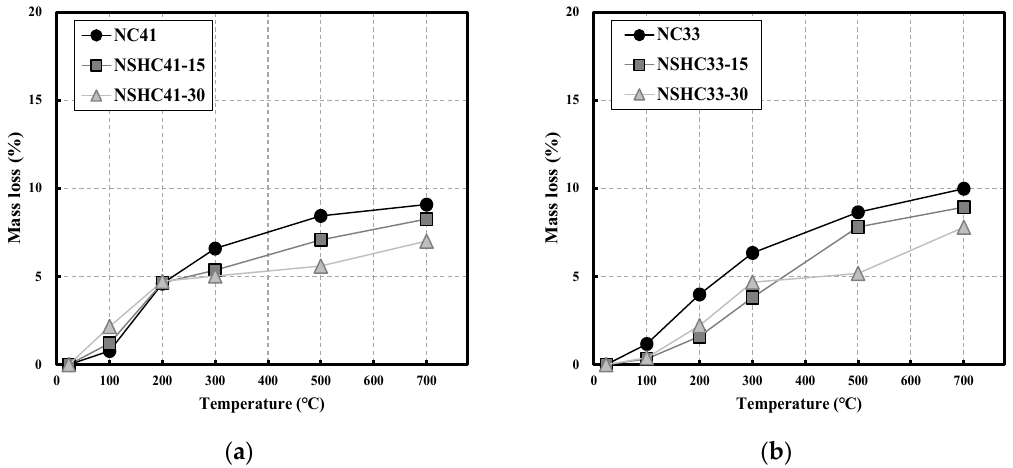
Figure 6. Mass loss of NC and NSHC after high ‐ temperature exposure: ( a ) W/B 41; ( b ) W/B 33. For W/B 33 (Figure 6b), NC33 showed a higher mass loss (%) than that of the speci ‐ mens with NSH mixed in all temperature ranges. Similar to NC41, the mass loss was 6.34% up to 300 °C, and at 700 °C, the mass loss increased to approximately 10%. NSHC33 ‐ 30 showed a by 23% higher mass loss than NSHC33 ‐ 15 up to 300 ℃ , but at higher tempera ‐ tures, NSHC33 ‐ 15 showed a higher mass loss value. NSHC33 ‐ 15 showed a higher mass loss (%) than NSHC33 ‐ 30 by approximately 51% at 500 °C and approximately 20% at 700 °C. Additionally, the dehydration of the chemically adsorbed water in cement occurs at temperatures below 600 ℃ , and the decomposition of C ‐ S ‐ H calcium carbonate occurs above 600 °C. The mass loss (%) for NSHC with lower cement content than NC is relatively small, and it decreases as NSH replacement increases. Compared to the trend at 500 °C, the difference in mass loss (%) between NC and NSHC shows a decreasing